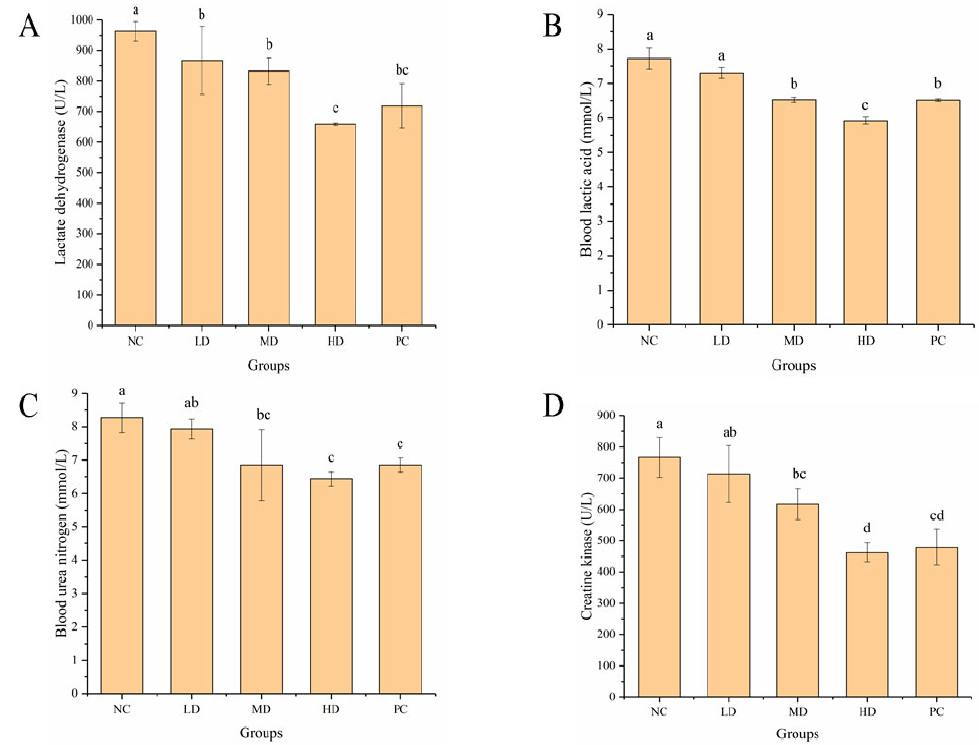
Figure 5. Effect of Hairtail fish ( Trichiurus lepturus ) glycoprotein (HGP) on serum biochemical indexes in mice. ( A ) Lactate dehydrogenase (LDH) in serum of mice from different groups. ( B ) Blood lactic acid (BLA) in serum of mice from different groups. ( C ) Blood urea nitrogen (BUN) in serum of mice from different groups. ( D ) Creatine kinase (CK) in serum of mice from different groups. Different lowercase letters represent significant differences between groups ( p < 0.05). NC: normal control, LD: low dose, MD: middle dose, HD: high dose, PC: positive control.